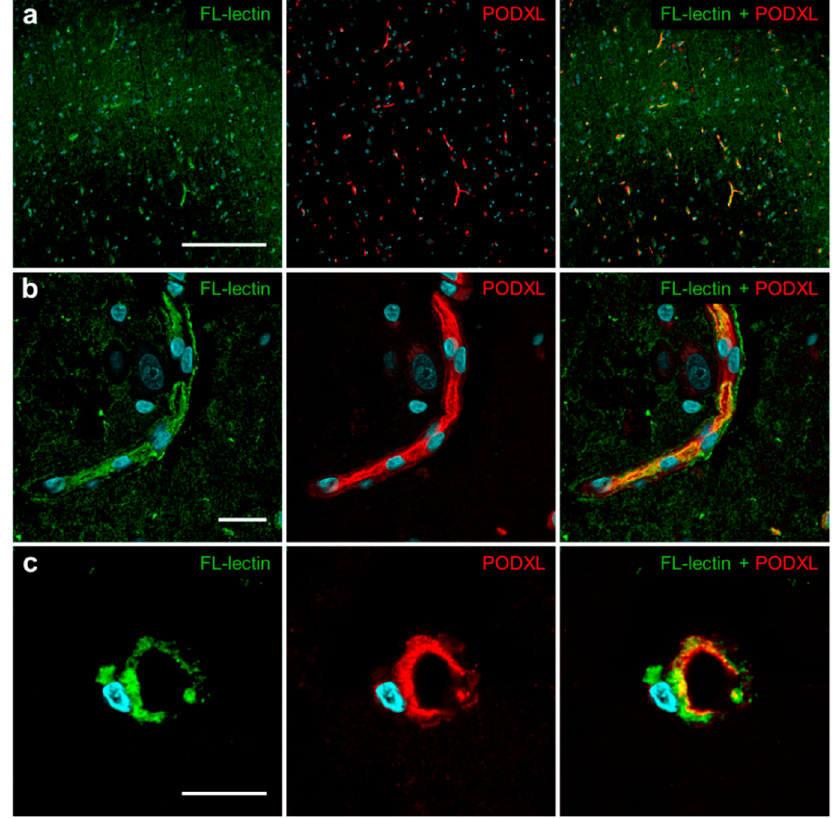
Figure 8. Localization of PODXL in the human cerebral cortex by confocal microscopy. Figure8. LocalizationofPODXLinthehumancerebralcortexbyconfocalmicroscopy. Immunohistochemical Immunohistochemical analysis of PODXL was performed using an anti-PODXL antibody (red). Blood analysis of PODXL was performed using an anti-PODXL antibody (red). Blood vessels were stained with vessels were stained with fluorescein (FL)-conjugated lectin (green), and nuclei were stained using fluorescein (FL)-conjugated lectin (green), and nuclei were stained using DAPI (blue). The images were DAPI (blue). The images were obtained by confocal microscopy. The three images were obtained from obtained by confocal microscopy. The three images were obtained from different regions of the sections. different regions of the sections. Scale bars: 200 μ m ( a ), 20 μ m ( b ), 10 μ m ( c ). Scale bars: 200 µ m ( a ), 20 µ m ( b ), 10 µ m ( c